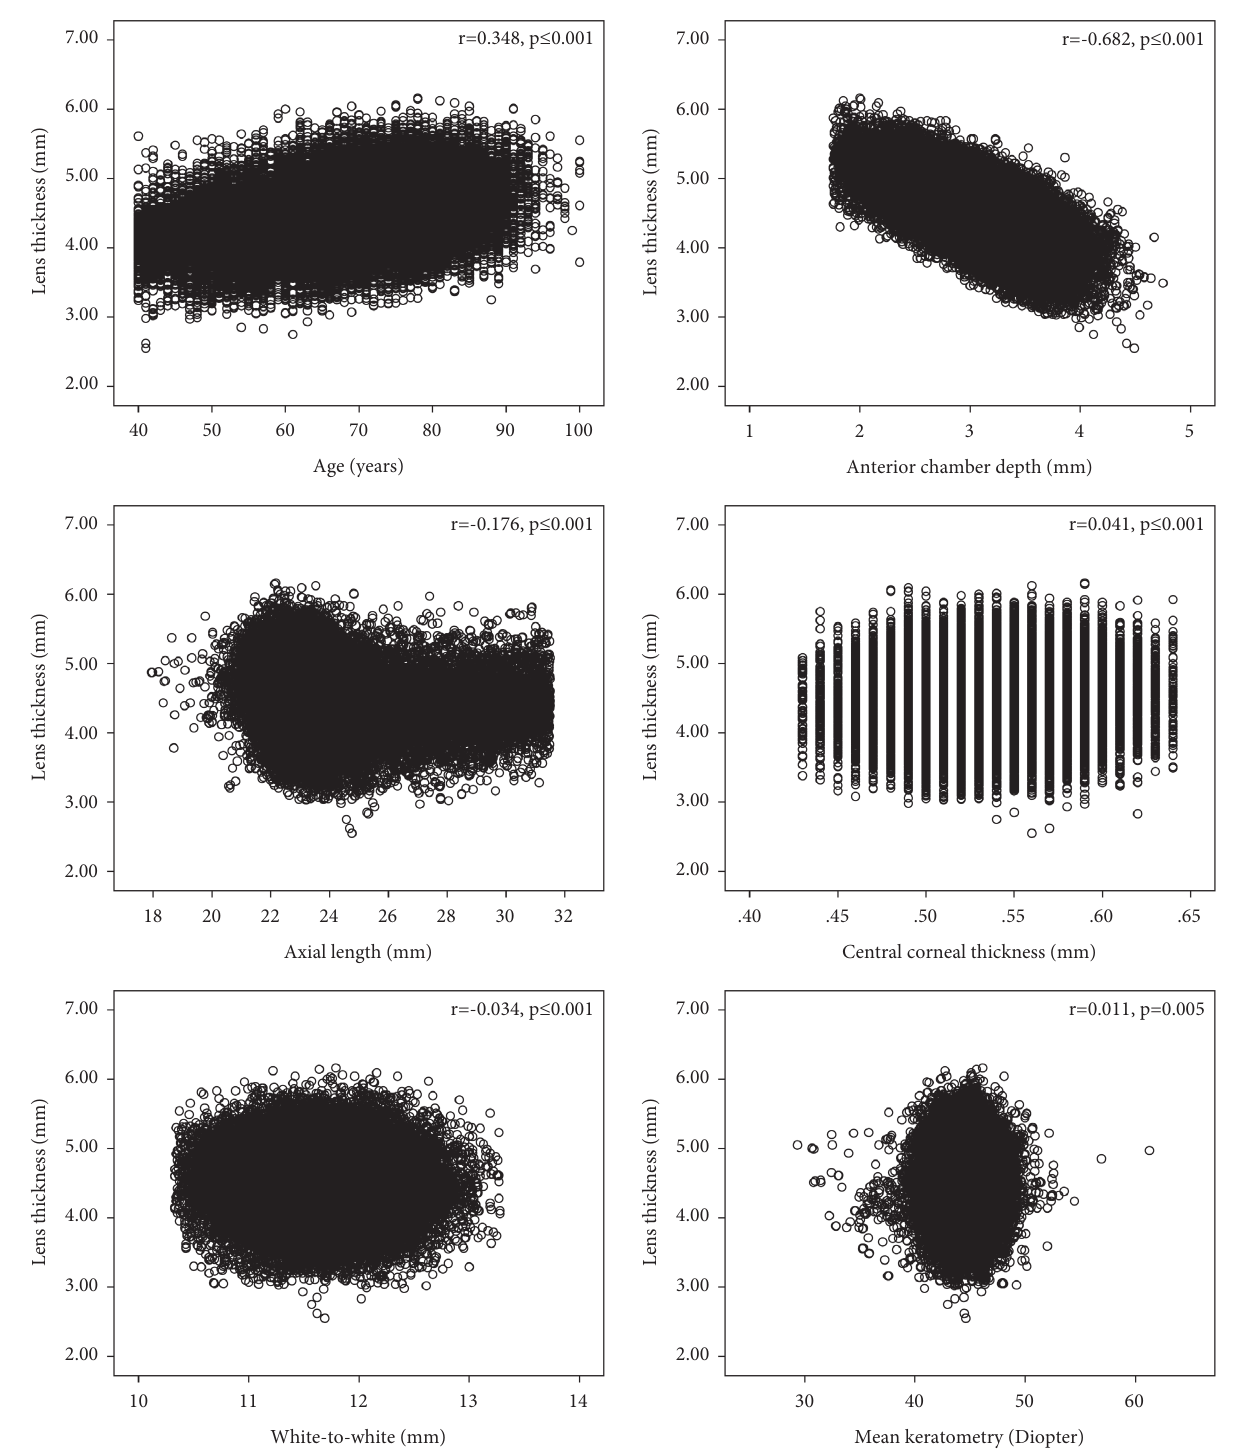
Figure 2: Correlations of lens thickness with age and other ocular biometric parameters. Table 2: Associations (Pearson’s correlation) between lens thickness and other ocular parameters in Chinese cataract patients.